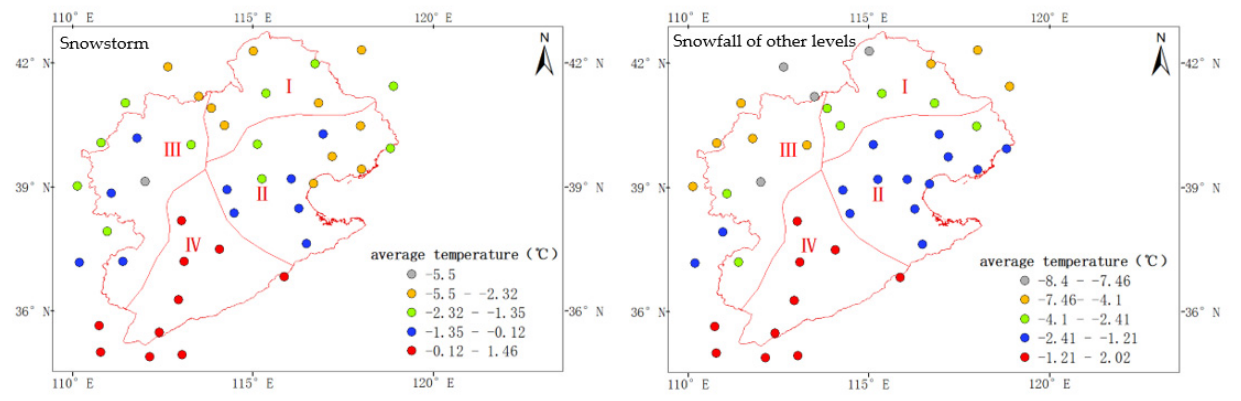
Figure 7. The average temperature for snowstorms and other snowfall events in all zones in the Haihe River Basin.